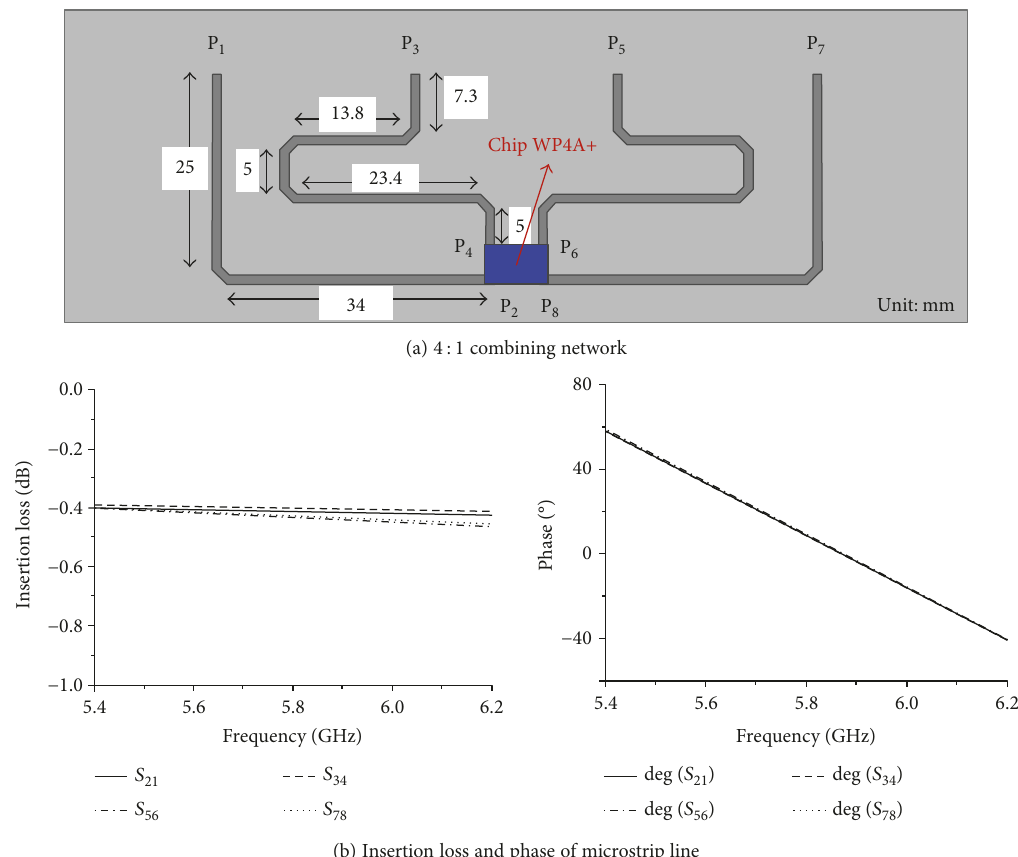
Figure 12: Design results of 4:1 combining